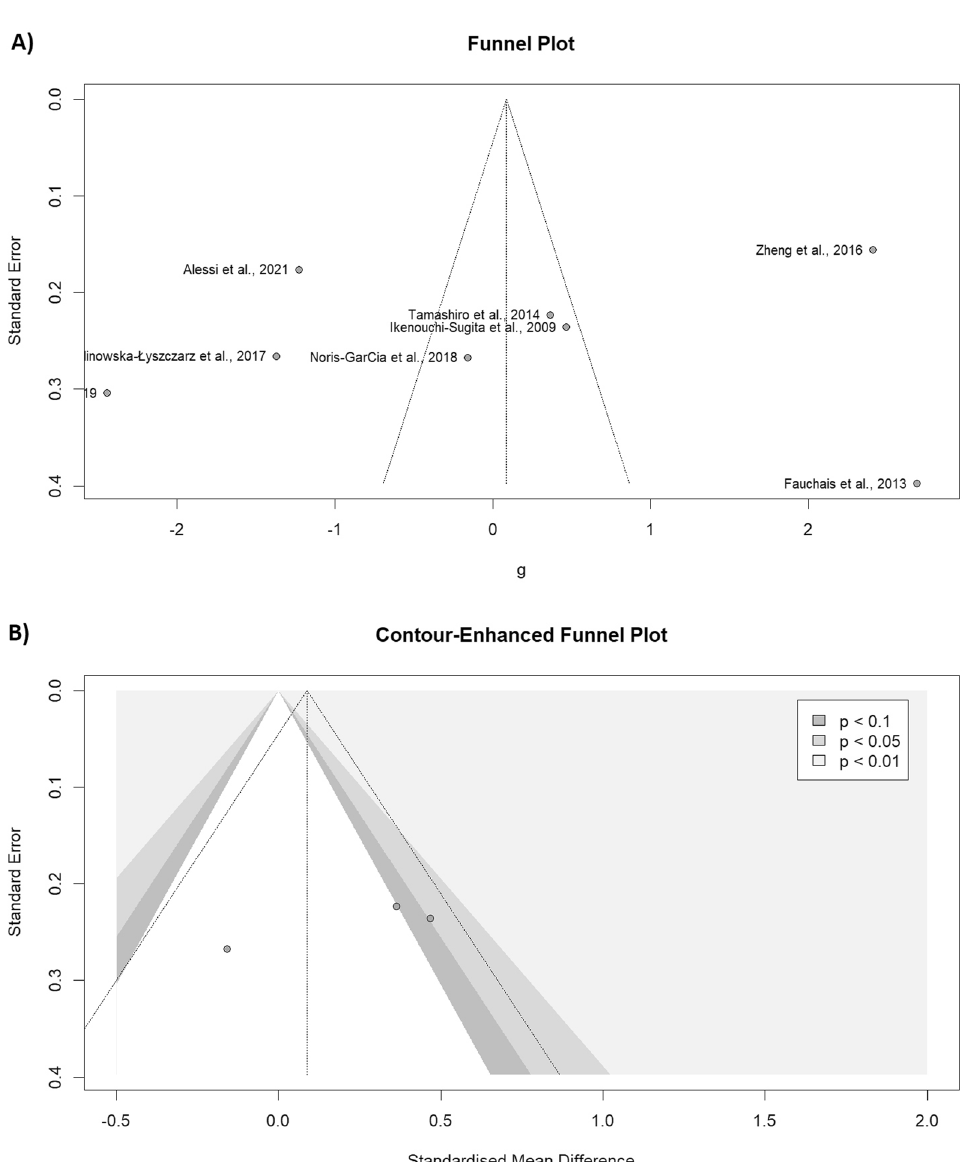
Fig. 3 A The funnel plot showing no evidence of publication bias, statistically supported by Egger’s regression test. B Counter-enhanced funnel